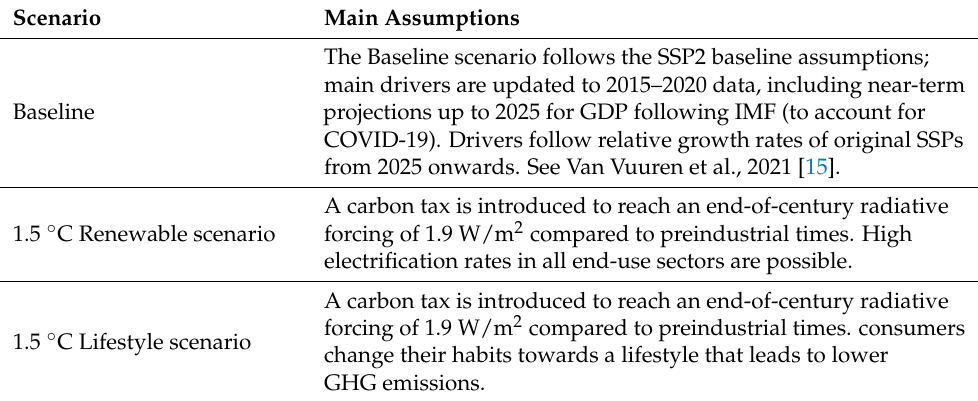
Table 4. Description of